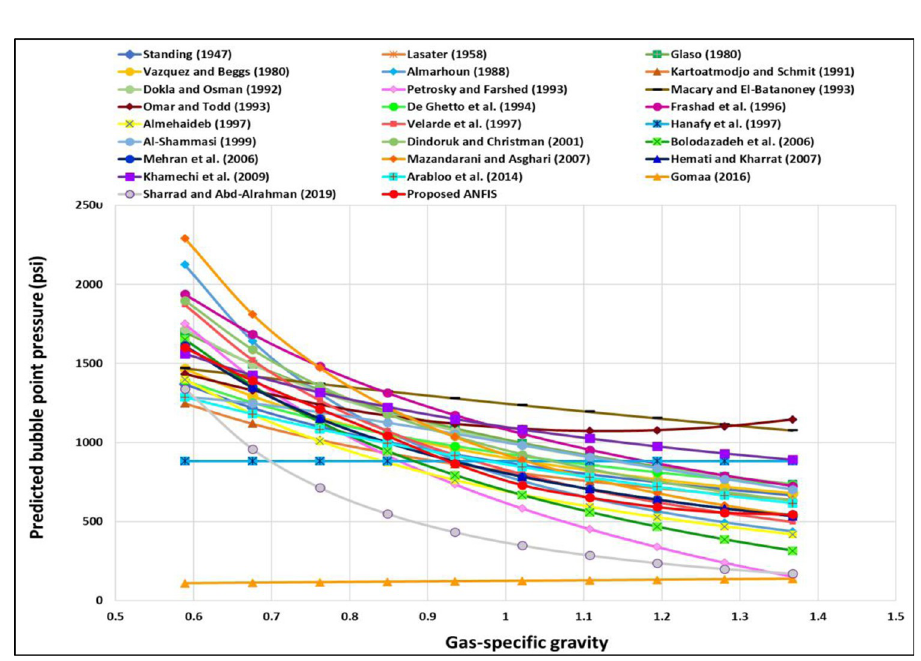
Fig 7. γ TrA of the ANFIS and existing models. g